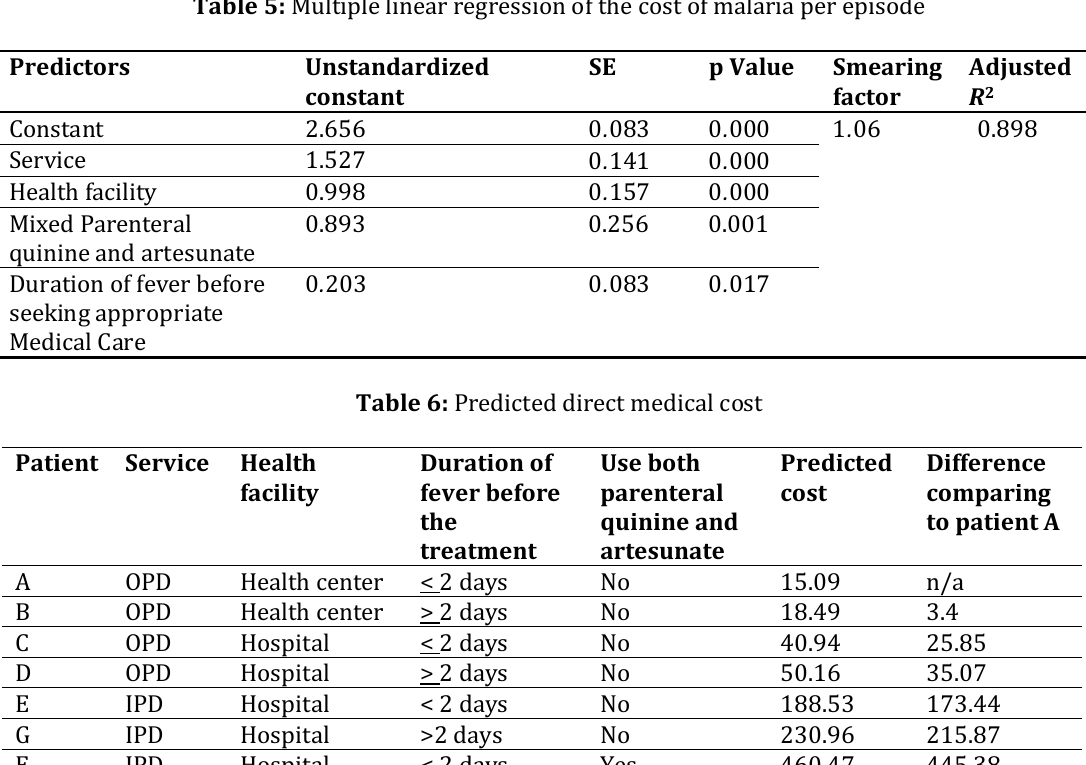
Table 5: Multiple linear regression of the cost of malaria per episode